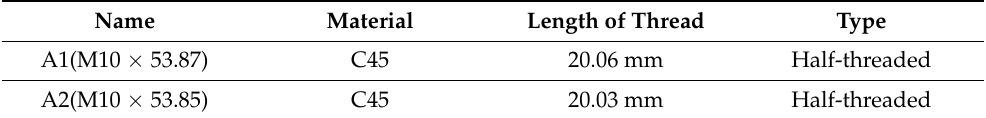
Table 2. Parameters of the bolt specimens.